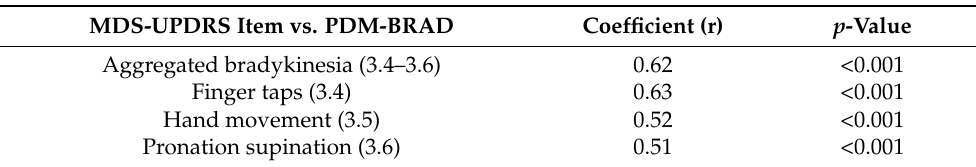
Table 3. The correlation of the MDS-UPDRS scores on the bradykinesia items to the PDM-BRAD score using Pearson’s